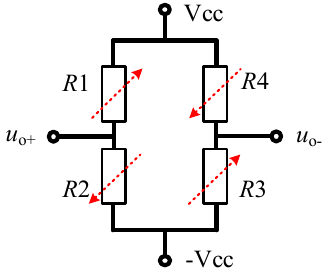
Figure 3. The equivalent Wheatstone bridge model of the TMR sensor.